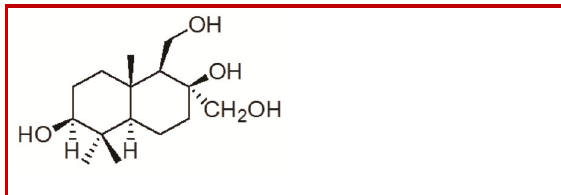
Figure 1: Chemical structure of sulphureuine